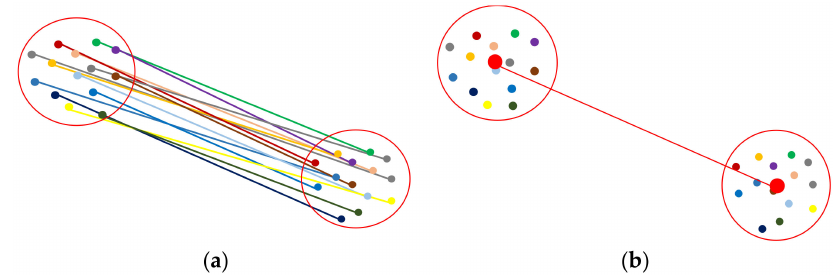
Figure 10. Definition of optimal opening. ( a ) opening candidates in an opening area. ( b ) extracted optimal opening position (each opening candidate shown in a different colour; red circle: buffer; red point: optimal opening position).